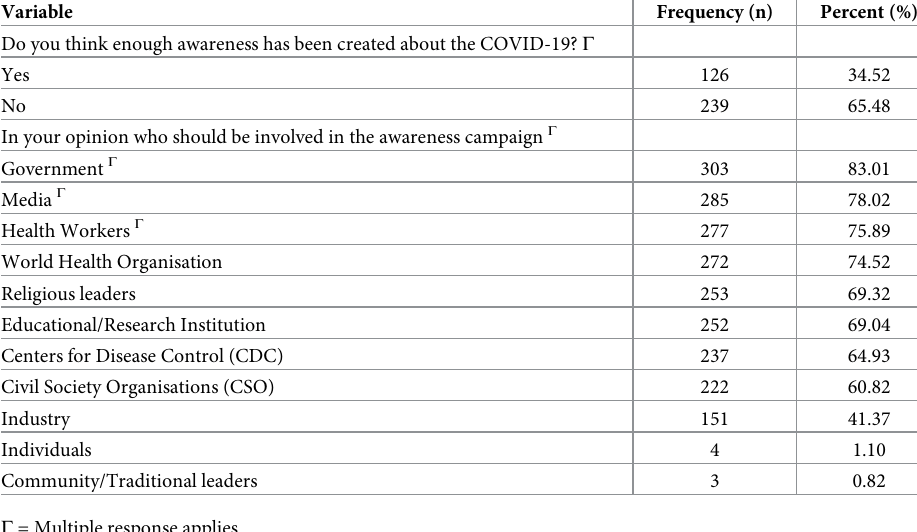
Table 2. Awareness among the general public on COVID-19 pandemic (n = 365).